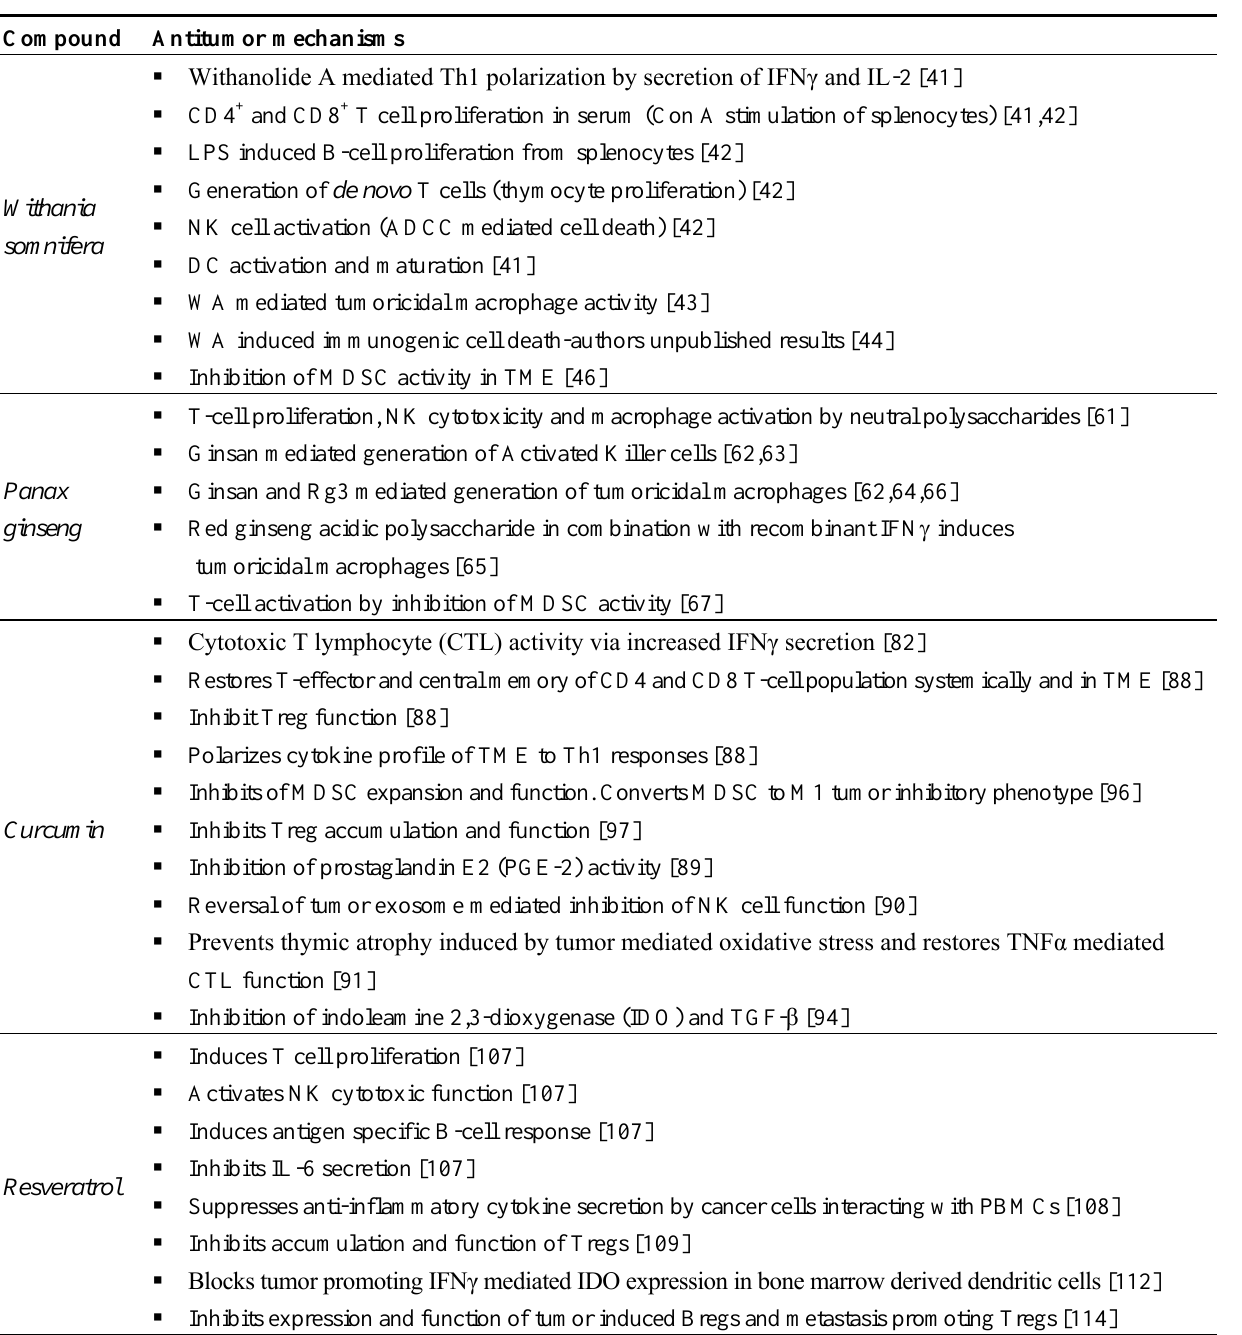
Table 1. Summary of antitumor immune mechanisms of selected dietary